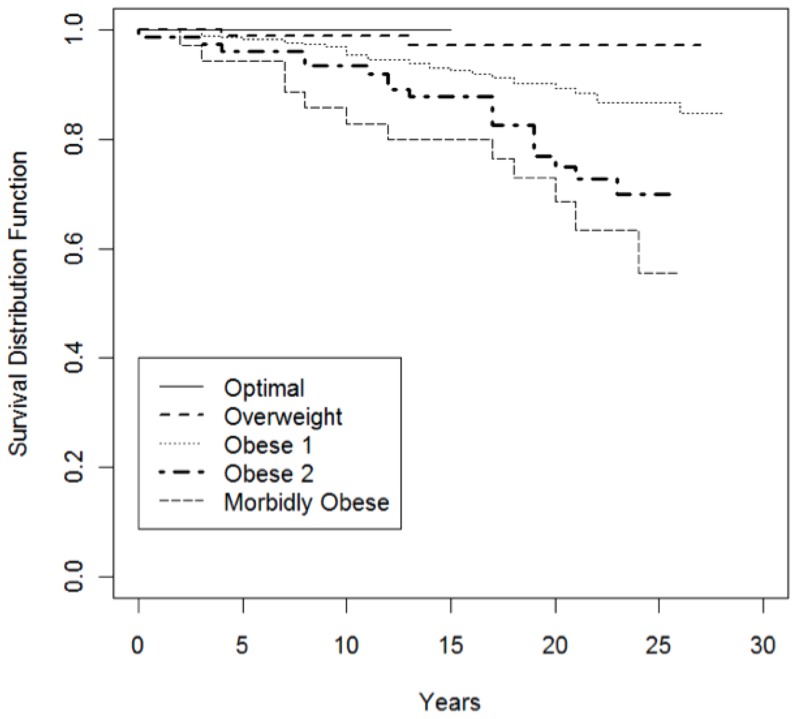
Wrestler survival probability for BMI by years from start of career.